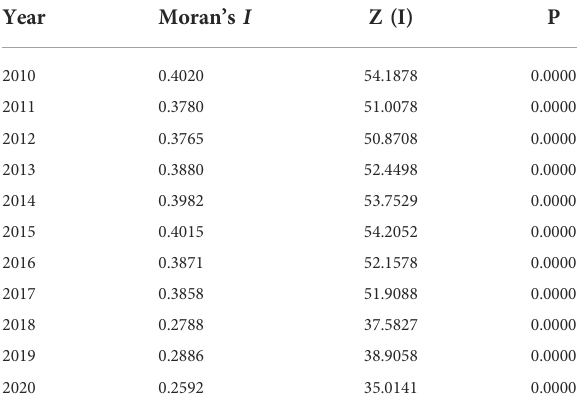
TABLE 2 Global Moran ’ s I index of industrial agglomeration in counties in the